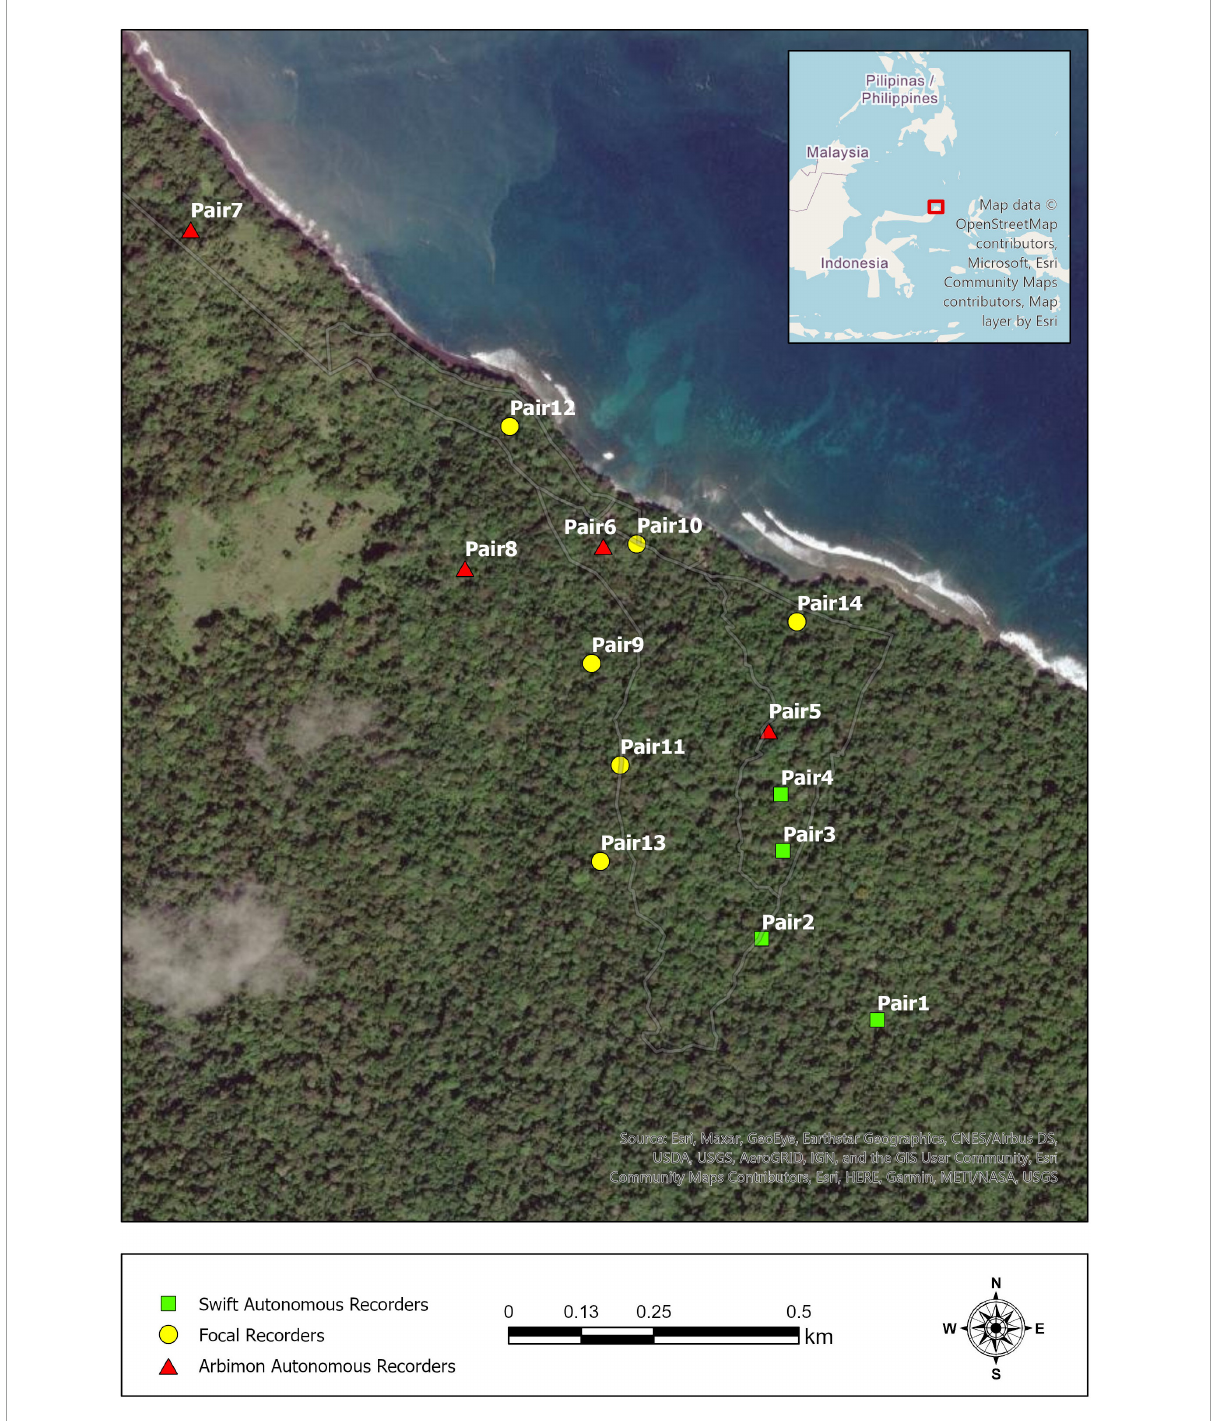
FIGURE1 Map of recording locations of tarsier pairs in Tangkoko National Park, North Sulawesi, Indonesia. Each point denotes the recording location of a tarsier pair, and the shape of the points reflects the type of recorder used (see section “Materials and methods” for